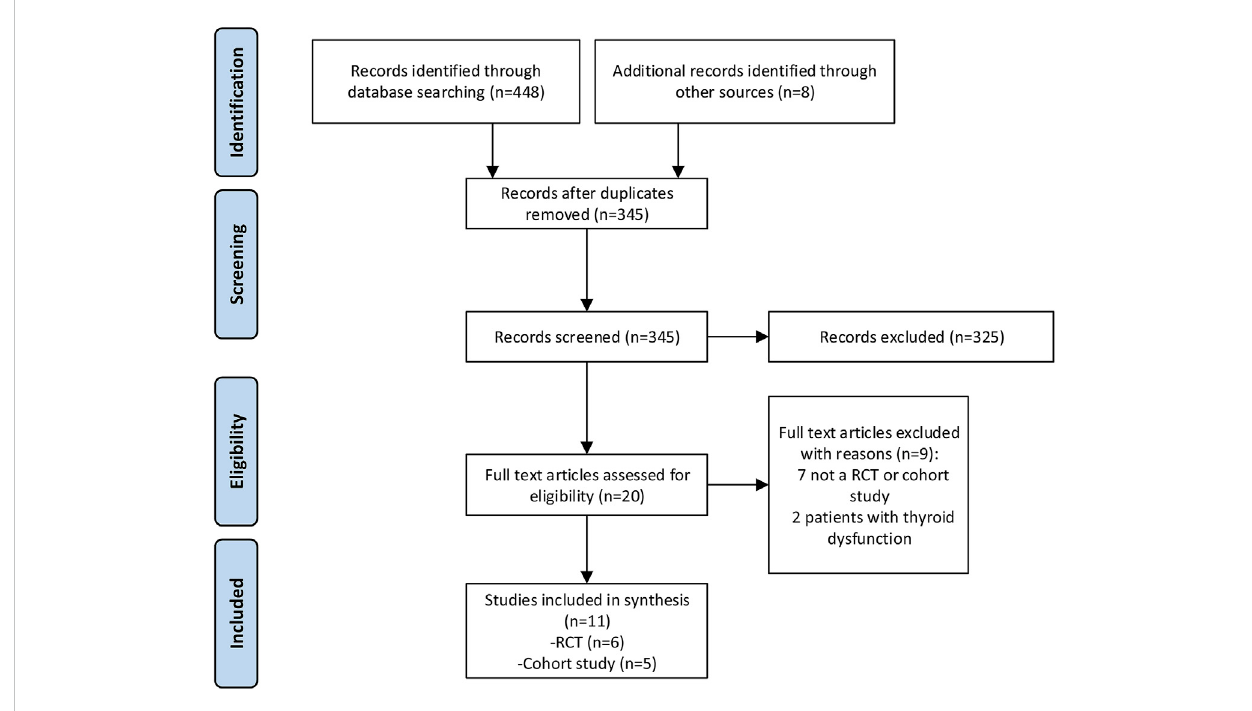
FIGURE 1 Study fl ow diagram.